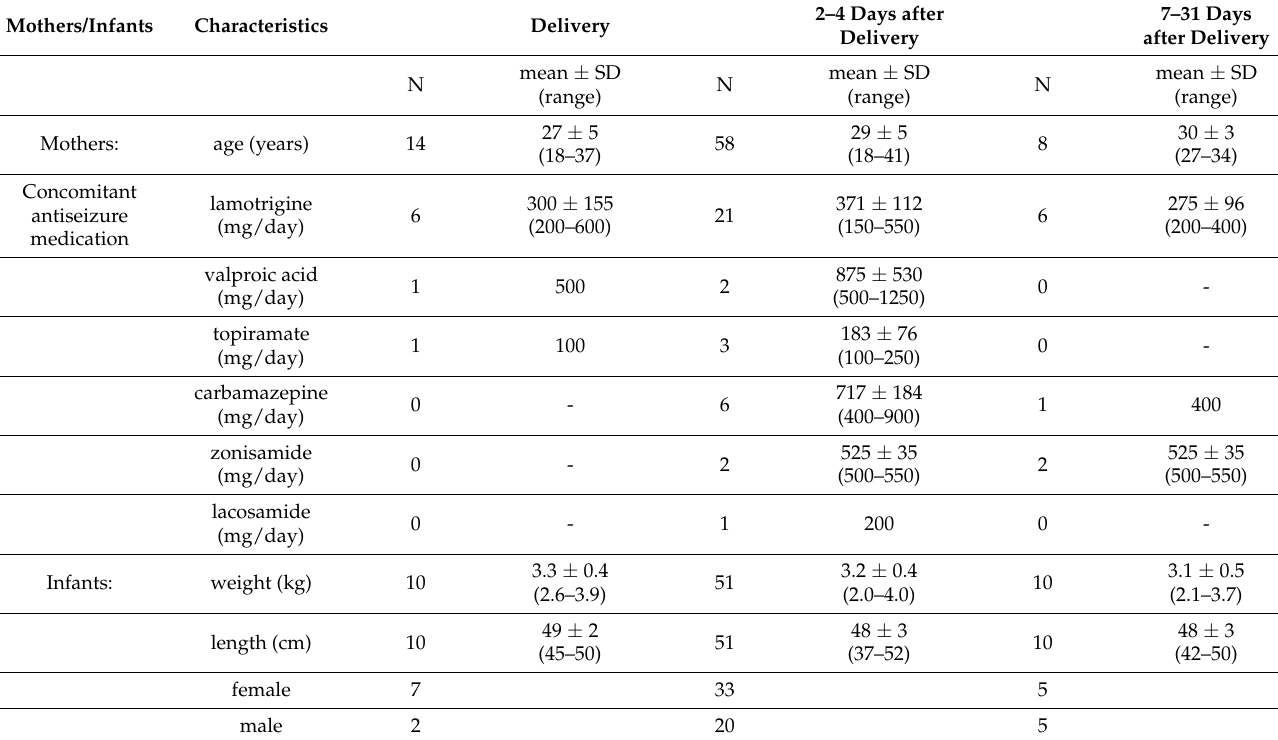
Table 1. Basic characteristics of mother and their